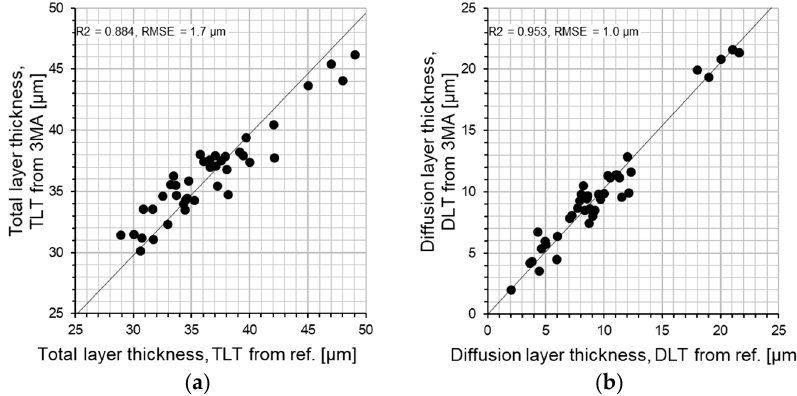
Figure 21. Results of the calibration to coating layer thickness in AlSi-coated PHS: ( a ) total layer thickness (TLT) and ( b ) diffusion layer thickness (DLT).